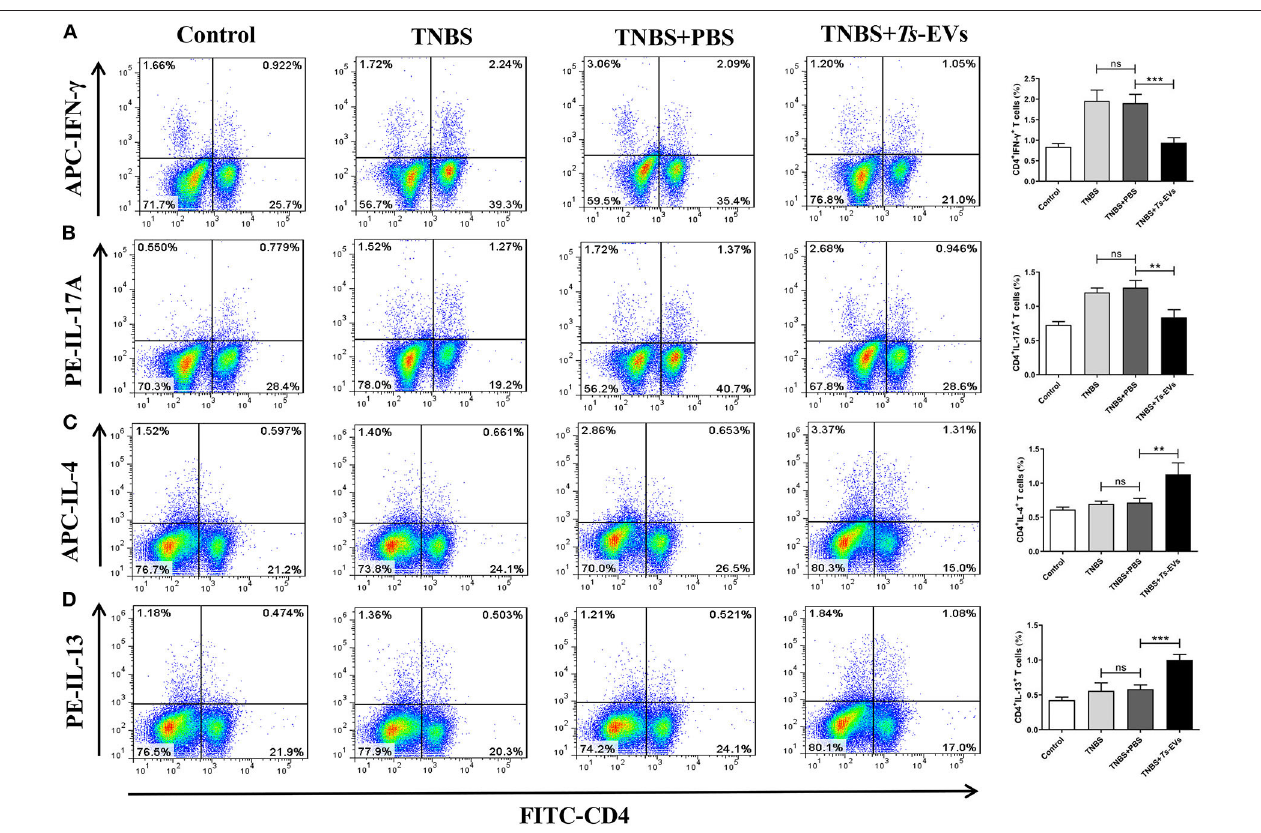
FIGURE 7 | Flow cytometry analysis of Th1, Th2 and Th17 cells in the MLNs of mice with TNBS-induced colitis pretreated or not with Ts -EVs. Mesenteric lymph node (MLNs) cells were isolated from the different groups of mice, stimulated with Leukocyte Activation Cocktail containing PMA, ionomycin and GolgiPlug TM (Brefeldin A), and stained with specific antibodies. (A) Th1 (CD4 + IFN- γ + ) cells. (B) Th17 (CD4 + IL-17A + ) cells. (C,D) , Th2 (CD4 + IL-4 + and IL-13 + ) cells. Results are shown as mean ± SD of each group ( n = 3). Statistical analysis was performed with one-way ANOVA followed by Tukey’s multiple-comparison test. ** p < 0.01, *** p <